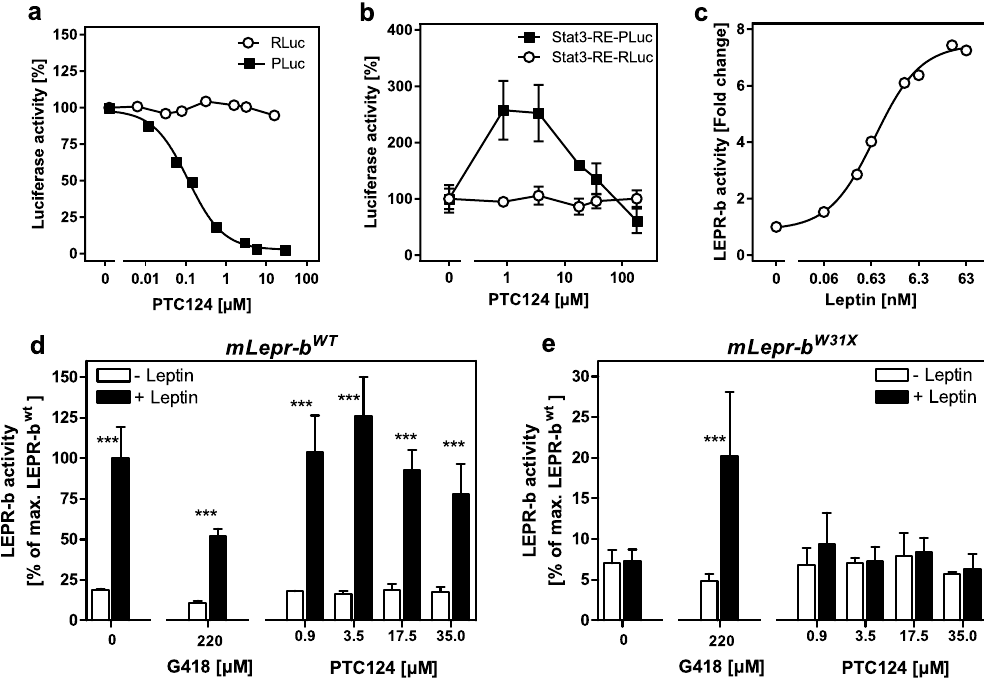
Figure 5. PTC124 has an off-target effect on PLuc and is not restoring mLEPR-b W31X signalling. ( a ) Lysates from HEK293 cells containing PLuc and RLuc were treated with rising concentrations of PTC124 during bioluminescence quantification. Shown is one representative measurement. ( b ) HEK293 cells were co- transfected with the STAT3-RE-PLuc and STAT3-RE-Rluc vector. Two days after the transfection, cells were treated for 24 h with rising concentrations of PTC124 (n = 3, SD). ( b ) HEK293 cells were co-transfected with the mLepr - b wt overexpression construct and STAT3-RE-RLuc. Two days after the transfection, cells were treated for 16 h with rising concentrations of murine leptin. Shown is one representative measurement. ( d , e ) HEK293 cells were co-transfected with either the mLepr - b wt - or mLepr - b W31X -pcDNA3.1 overexpression construct and with STAT3-RE-RLuc. Two days after the transfection, cells were treated for 24 h with G418 or with rising concentrations of PTC124 and for the last 16 h in addition with 6 nM murine leptin (n = 3, SD). Statistical significance between ( − ) and ( + ) leptin was assessed by t-tests with Bonferroni-Holm correction for multiple comparisons *** p <